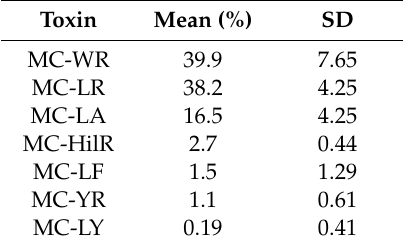
Figure4. IonchromatogramsobtainedfollowingUHPLC-MS / MS,showingquantitativeSRMtransitions for detected microcystin congeners in ( A ) the high level calibration standard and ( B ) the algal scum sample from Station 4. Table 2. MC congener contribution (as a percentage) to the total MC